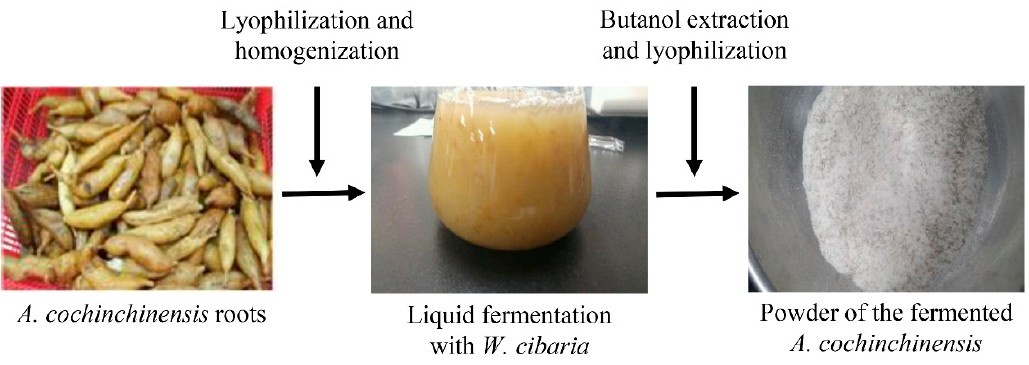
Figure 1. Preparation of BAW sample. BAW was obtained from the root of A. cochinchinensis after fermentation with W. cibaria , extraction with butanol, and lyophilization as described in the materials and methods.